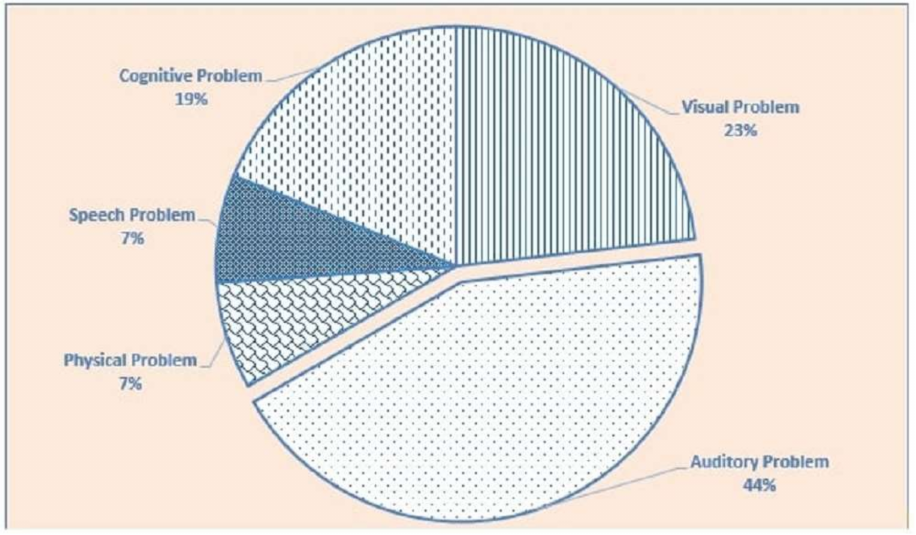
Figure 1. Worldwide ratio of people with several